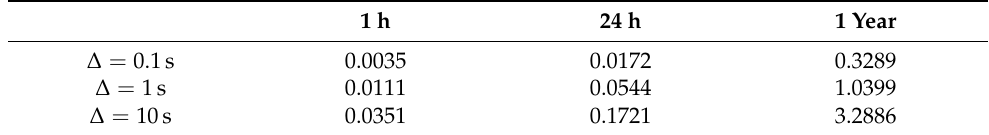
Table 2. SOC error s.d. (%) due to current measurement error. 1 h 24 h 1 Year ∆ = 0.1s